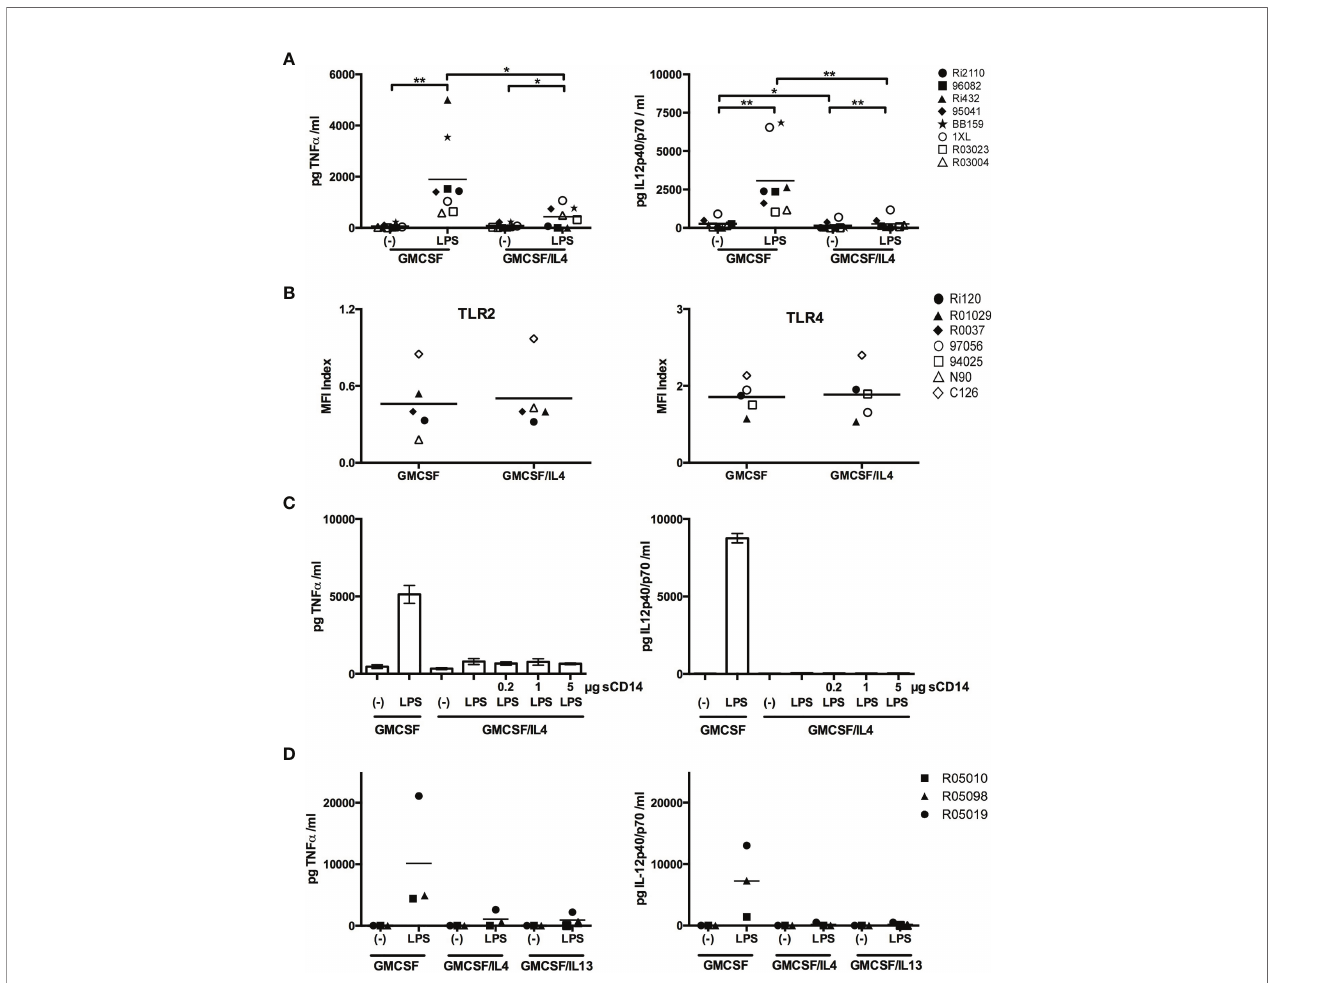
FIGURE 3 | Comprehensive analysis of the impairment of LPS-induced cytokine production in IL-4-exposed microglia. (A) GMCSF or GMCSF/IL-4-exposed microglia were stimulated with 100 ng LPS/ml for 16h. TNF a and IL-12p40/p70 levels are expressed in pg/ml, *p < 0.05 **p < 0.01 paired t-test. (B) Cell surface expression of TLR2 and TLR4 on GMCSF and GMCSF/IL-4-exposed microglia were assessed by fl ow cytometry and expressed as MFI index [(MFI protein of interest – MFI isotype control )/MFI isotype control ]. (C) GMCSF/IL-4-exposed microglia were stimulated with 100 ng LPS/ml for 16h in the presence of increasing concentrations of soluble CD14. (D) TNF a and IL-12p40/p70 production levels (in pg/ml) of microglia exposed to GMCSF, GMCSF/IL-4 or GMCSF/IL-13 that were stimulated with 100 ng LPS/ml for 16h. Different symbols represent different donors and horizontal lines indicate